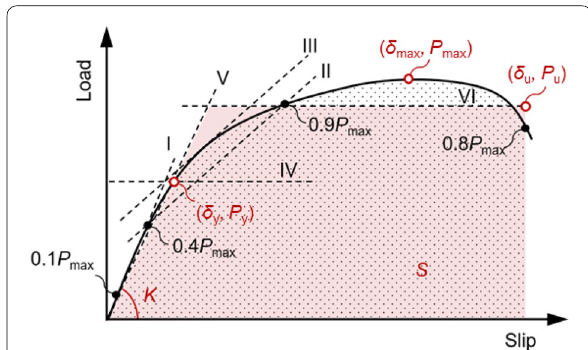
Fig. 10 Method for obtaining the characteristics values by perfect elasto-plastic